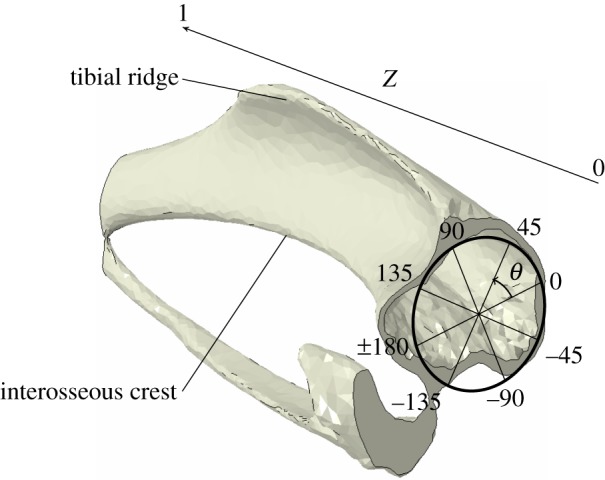
Angular (θ) and longitudinal (Z) coordinates used in the cylindrical coordinates system.